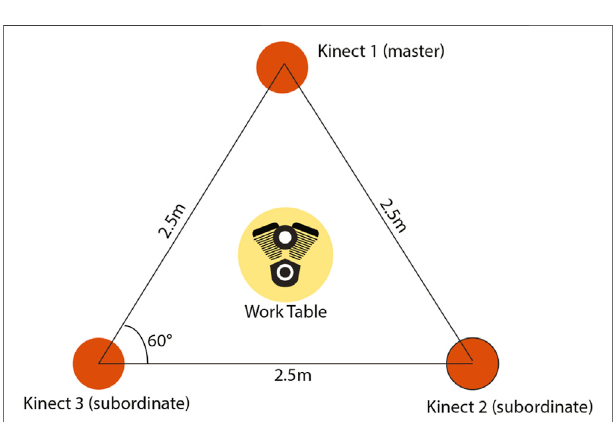
FIGURE 2 | Studio setup for volumetric capture. Three Azure Kinect cameras are kept 60 ° apart in the form of an equilateral triangle.